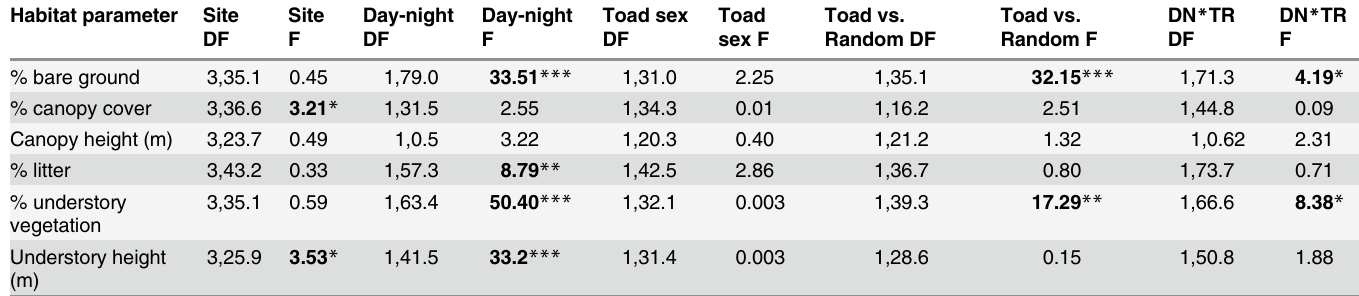
Table 2. Effects of site, sex, time (day vs. night) and usage by toads (used vs. random nearby site) on attributes of microhabitats used by (and available to) radio-tracked cane toads on the island of Hawai ’